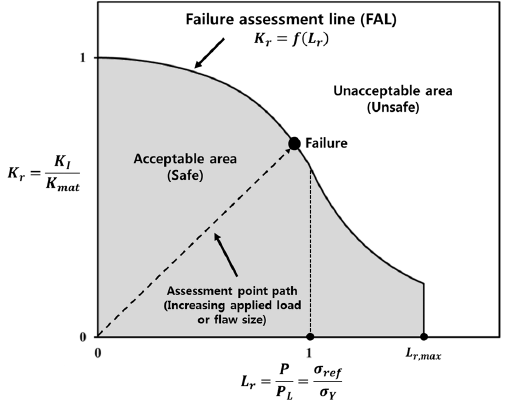
Figure 1. Schematic illustration of the failure assessment diagram for a structure with flaws.